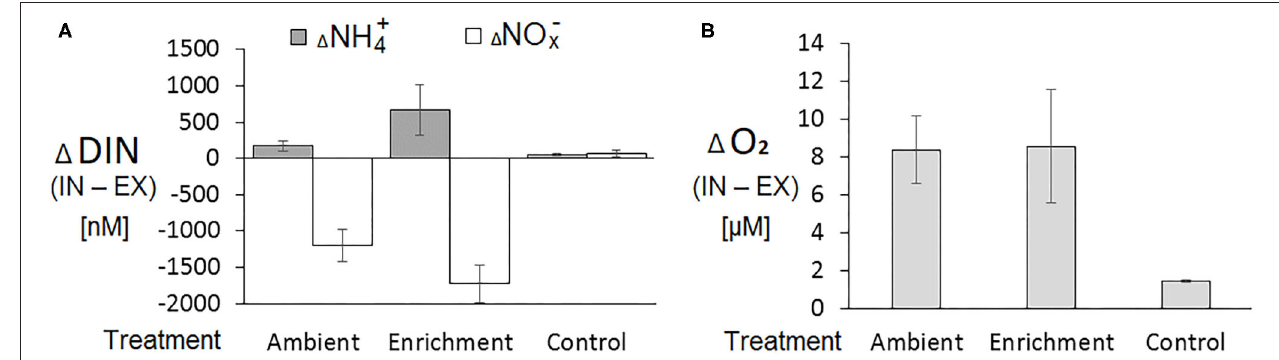
FIGURE 1 | Changes in dissolved inorganic nitrogen and dissolved oxygen concentrations between IN-EX samples collected from sponge and control (no sponge) aquaria. (A) Dissolved inorganic nitrogen (DIN) as ammonium (NH + 4 ) and nitrates (NO − 2 + NO − 3 = NOx); (B) Dissolved oxygen. Averages ± SD. n = 39, 32, and 6 for ambient, enrichment and control treatments,